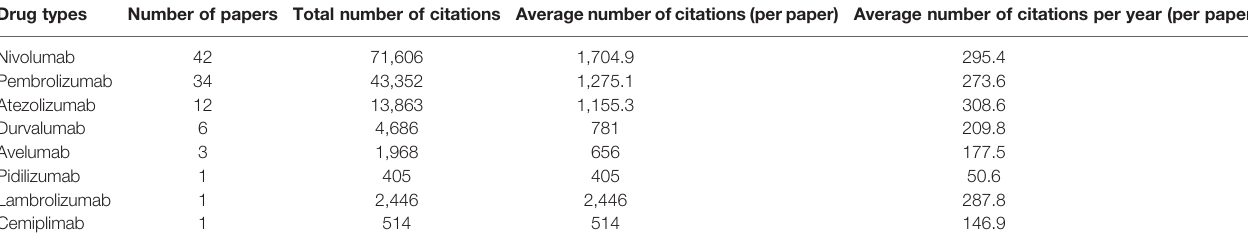
TABLE 5 | Types of drugs investigated in the top-cited papers on anti-PD1/PDL1 immunotherapy. Drug types